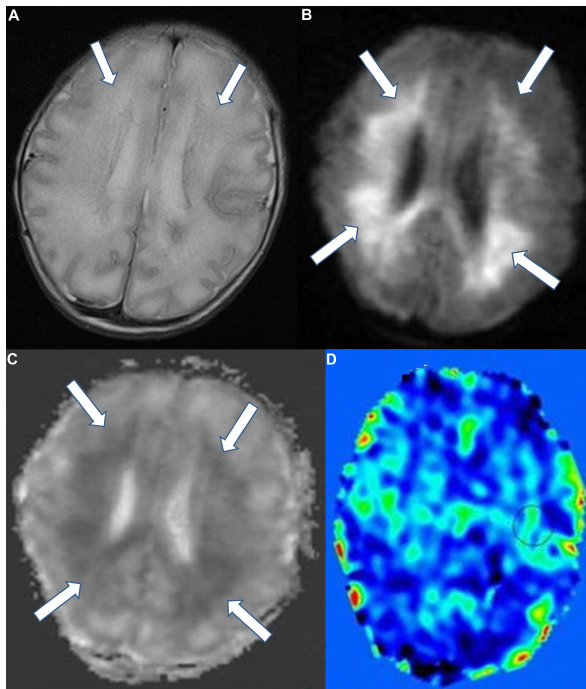
Fig. 3. Images of a male HIE neonate (3 days old, gestational age of 37 weeksand6days,andweightof2.45kg)withahistoryofperinatalas- phyxiaduetoanintertwinedumbilicalcord. (A)T2WIshowedhyper- intensity at the bilateral corona radiata area (arrows). (B) DWI showed hy- perintensityinthesameregions(arrows). (C)ADCmapshowedhypointen- sity in the same regions (arrows). (D) No abnormal perfusion was observed on the CBF images, but the CBF value in the circled area was higher than that of the control group.